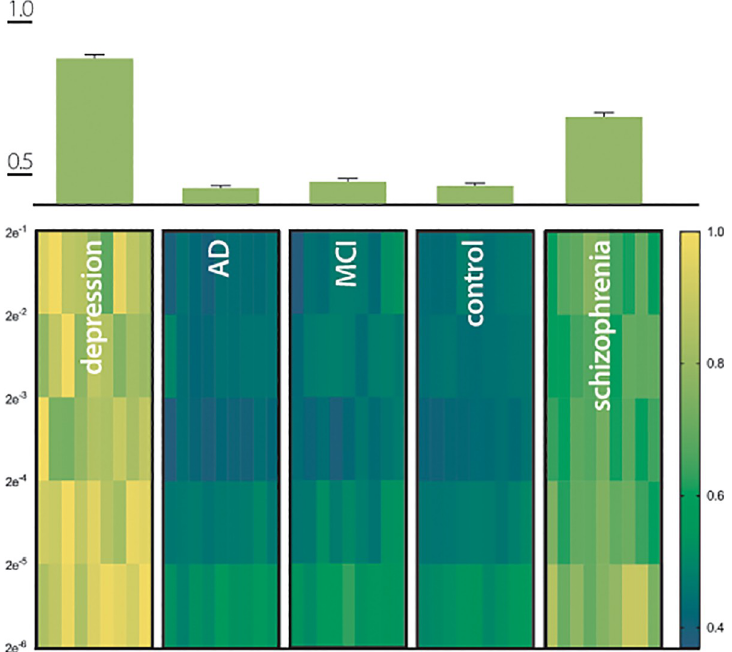
Fig 3. Power spectral density (PSD) of QP for different patient groups. (A) PSD for each QP electrode with frequency band of 2 -n (n = 1 ... 5) and a window of 64s with 32s overlap, normalized values according to methods. (B) Graphic depiction of the mean and SEM of the normalized PSD of each patient